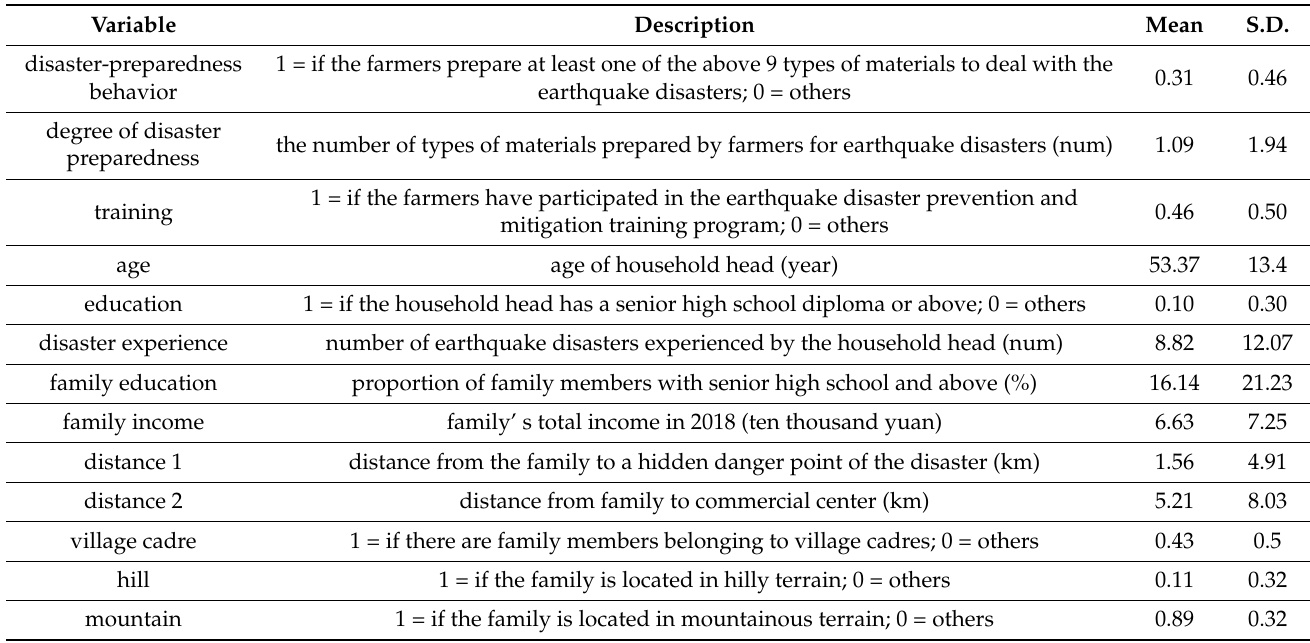
Table 1. The definition and data description of the variables in the